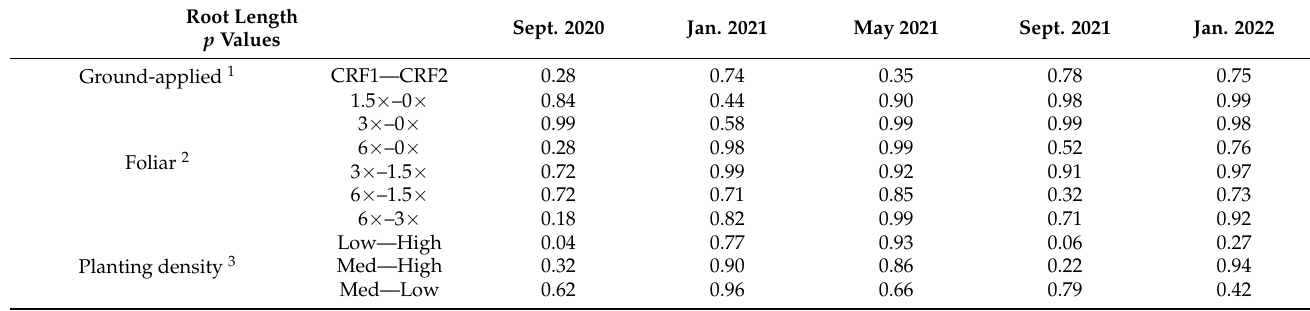
Table 5. p -values obtained via a three-way ANOVA followed by Tukey’s post hoc test, corresponding to the total root length of ‘Ray Ruby’ grapefruit grafted on ‘Kuharske’ citrange planted in flatwood soils located in Fort Pierce, FL, USA, and treated with ground-applied fertilizer, foliar fertilizer and different planting densities from September 2020 to January 2022. Bold values were considered to be significantly different ( p < 0.05).